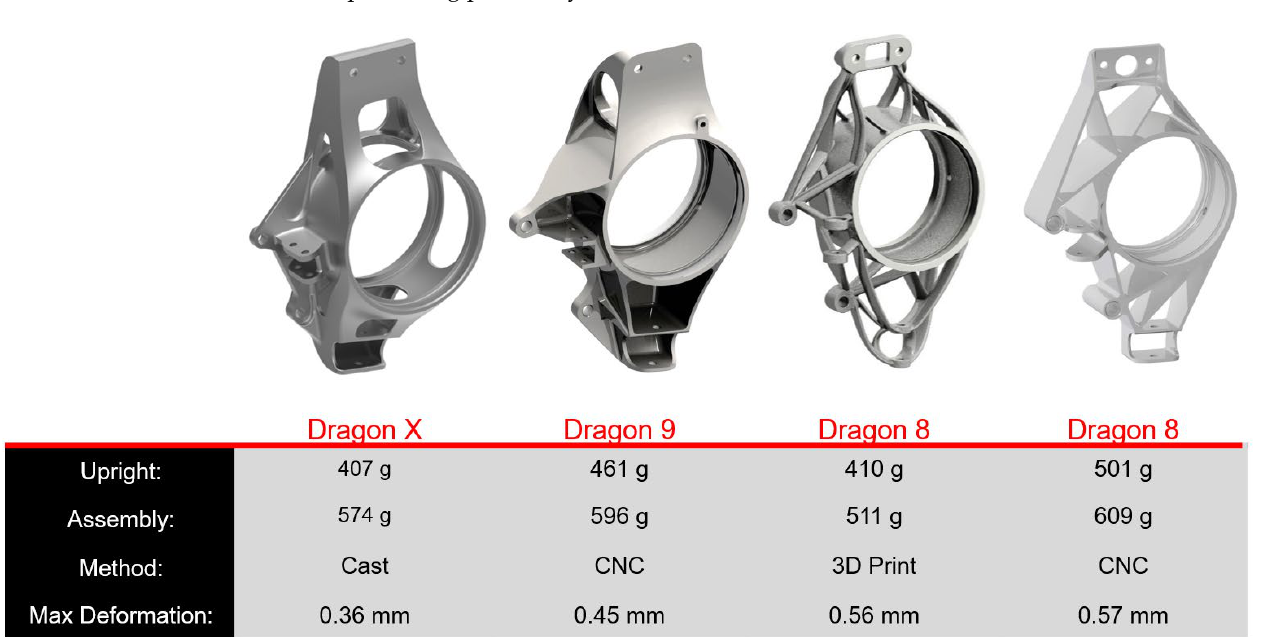
Figure 5. Comparison of parameters of the different Formula Student versions.